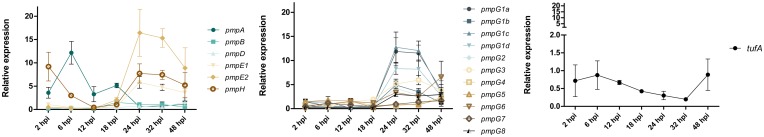
Transcription of the pmp genes along development.Transcript levels of pmpA through pmpG8 and tufA of C. psittaci Cal10 were measured at 2, 6, 12, 18, 24, 32 and 48 hpi by real-time RT-qPCR. Two biological and two technical replicated were analyzed for each sample. Error bars are based on the standard error of the mean.